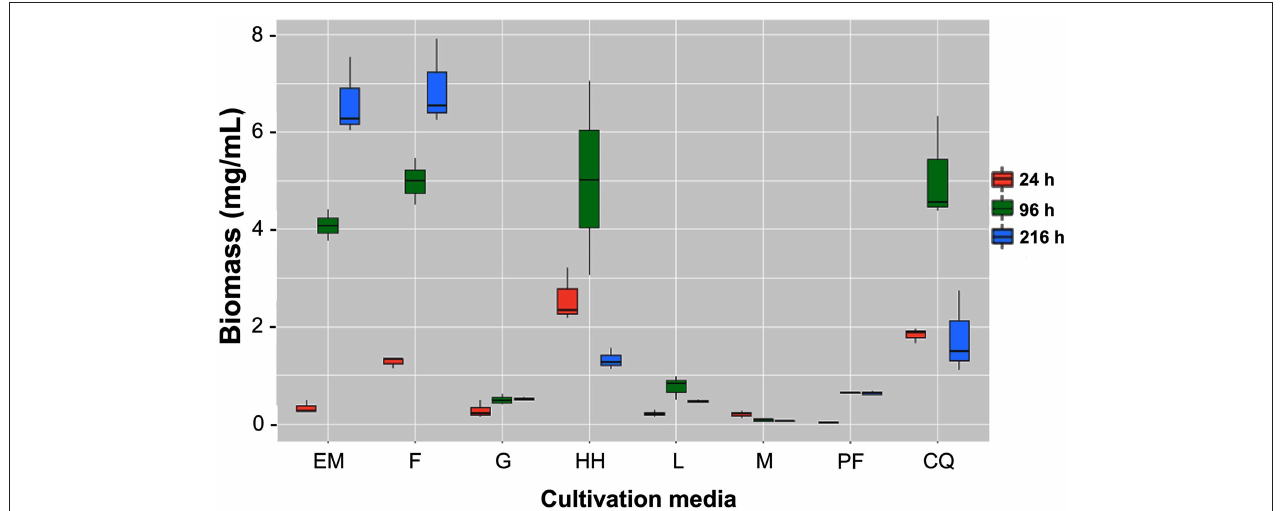
FIGURE 2 | Biomass yield through time. B. bassiana grown in M: minimal medium, minimal medium plus simple carbon substrate (G, glucose; L, laminarin; CQ, colloidal chitin), and minimum medium plus complex carbon substrate (EM, E. melanocampta powder; HH, H. hampei powder; F, F. oxyparum powder; PF, P. variabilis powder). The boxes display the central tendency and spread for each treatment at three different times: 24h (red), 96h (green), and 216h (blue). The horizontal line inside each box shows the median for each treatment. EM and F are associated with constant yield increase through time while HH and CQ yields decreases after 96h. G, L, and PF display poor yield increase through time with M showing decreasing yields from the beginning of the cultivation. p < 0.05, n ≥ 3 independent